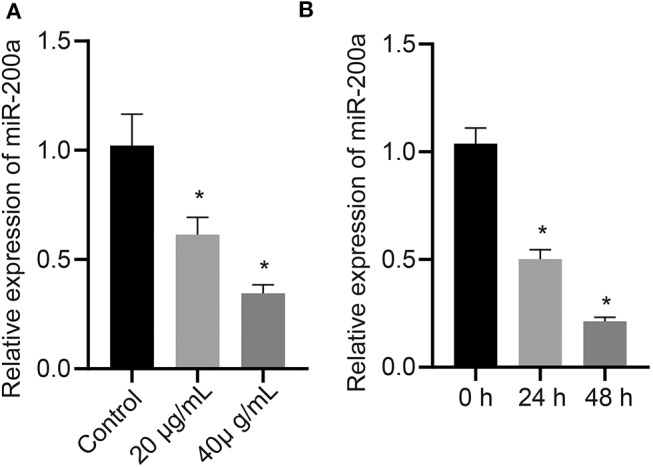
miR-200a is downregulated in ox-LDL-induced HUVECs. (A) miR-200a expression in HUVECs treated with 0, 20, and 40 μg/ml ox-LDL at 24 h determined using RT-qPCR, normalized to U6. (B) miR-200a expression in HUVECs treated with 20 μg/ml ox-LDL at 0, 24, and 48 h determined using RT-qPCR, normalized to U6. *(relative to untreated HUVECs) indicates p < 0.05 by one-way ANOVA/Tukey's post-hoc test.